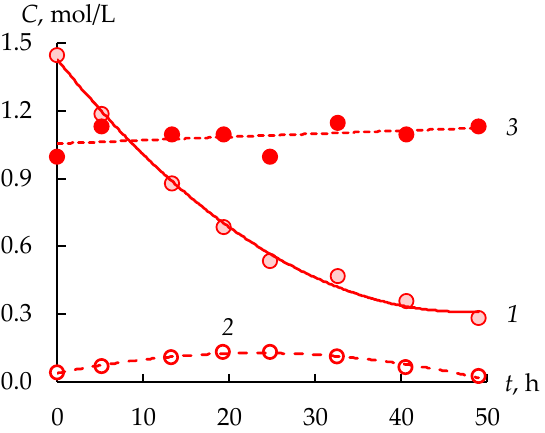
Figure 7. Sulfuric acid concentrations in the feed (1), intermediate (2) and concentrate (3) tanks during the second stage.